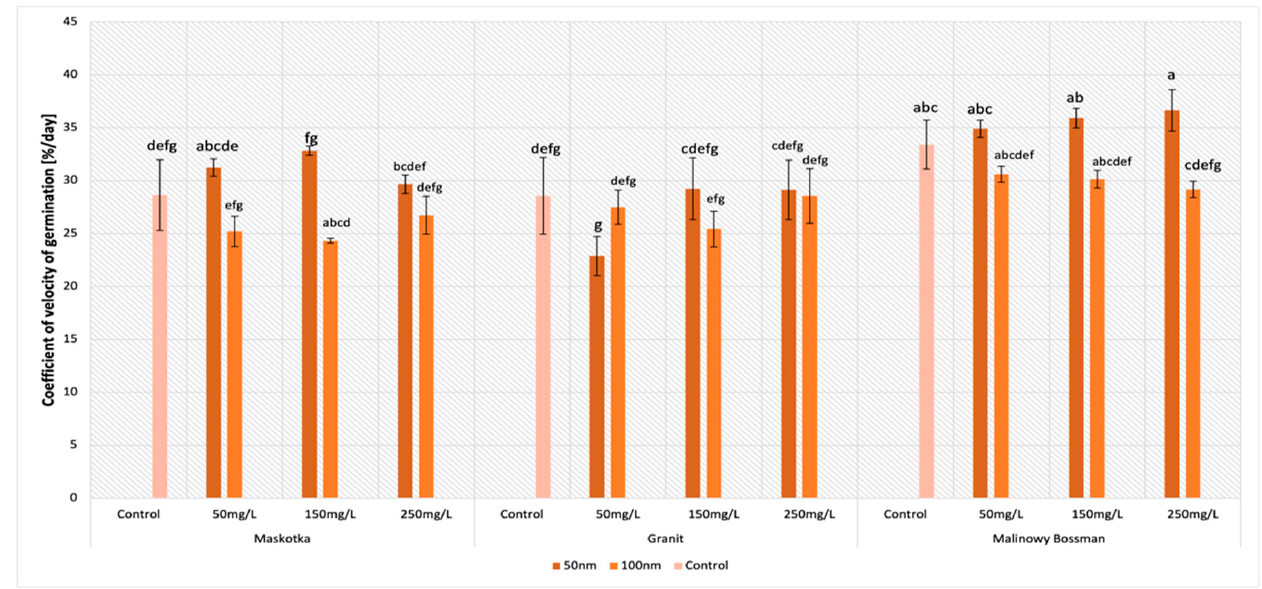
Figure 6. Effect of zinc oxide NPs on the coefficient of velocity of germination of tomato seeds after 5 days of incubation. All data are the mean of 3 replicates and vertical bars demonstrate standard deviation (±SD). Different letters indicate the significant differences for p -value ≤ 0.05 (Table A4).